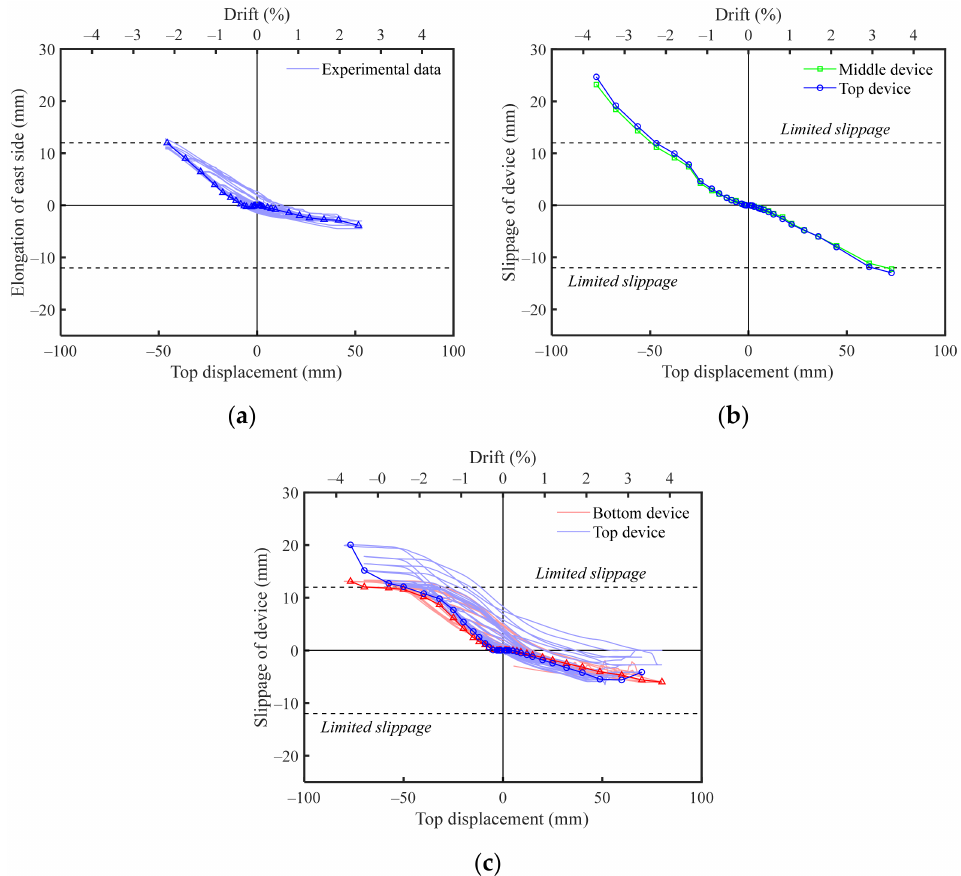
Figure 13. Results of vertical slippage and elongation. ( a ) Elongation in W0; ( b ) Vertical slippage in W1-R; ( c ) Vertical slippage in